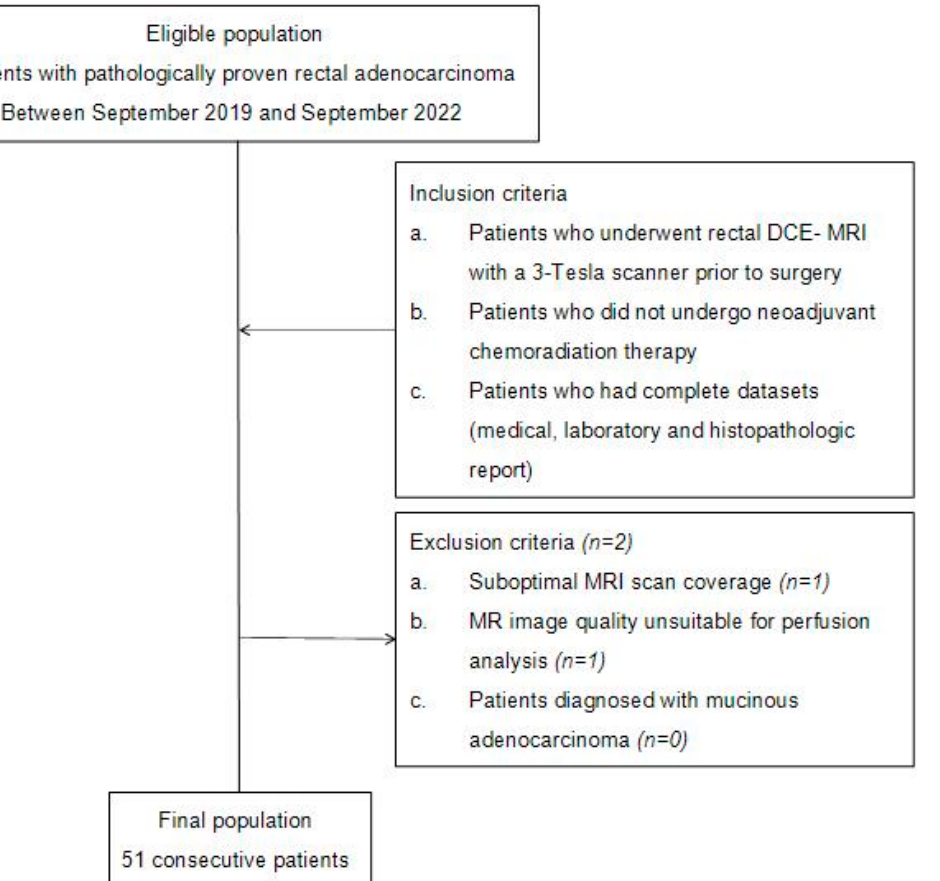
Figure 1. Flowchart of case accrual process.